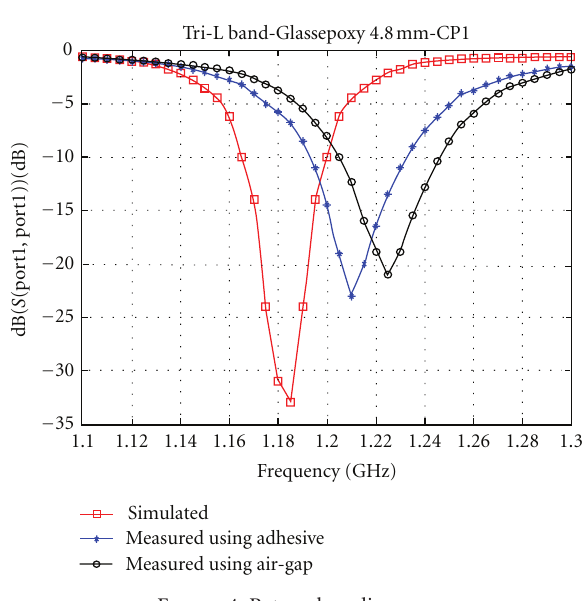
Figure 4: Return loss diagram.